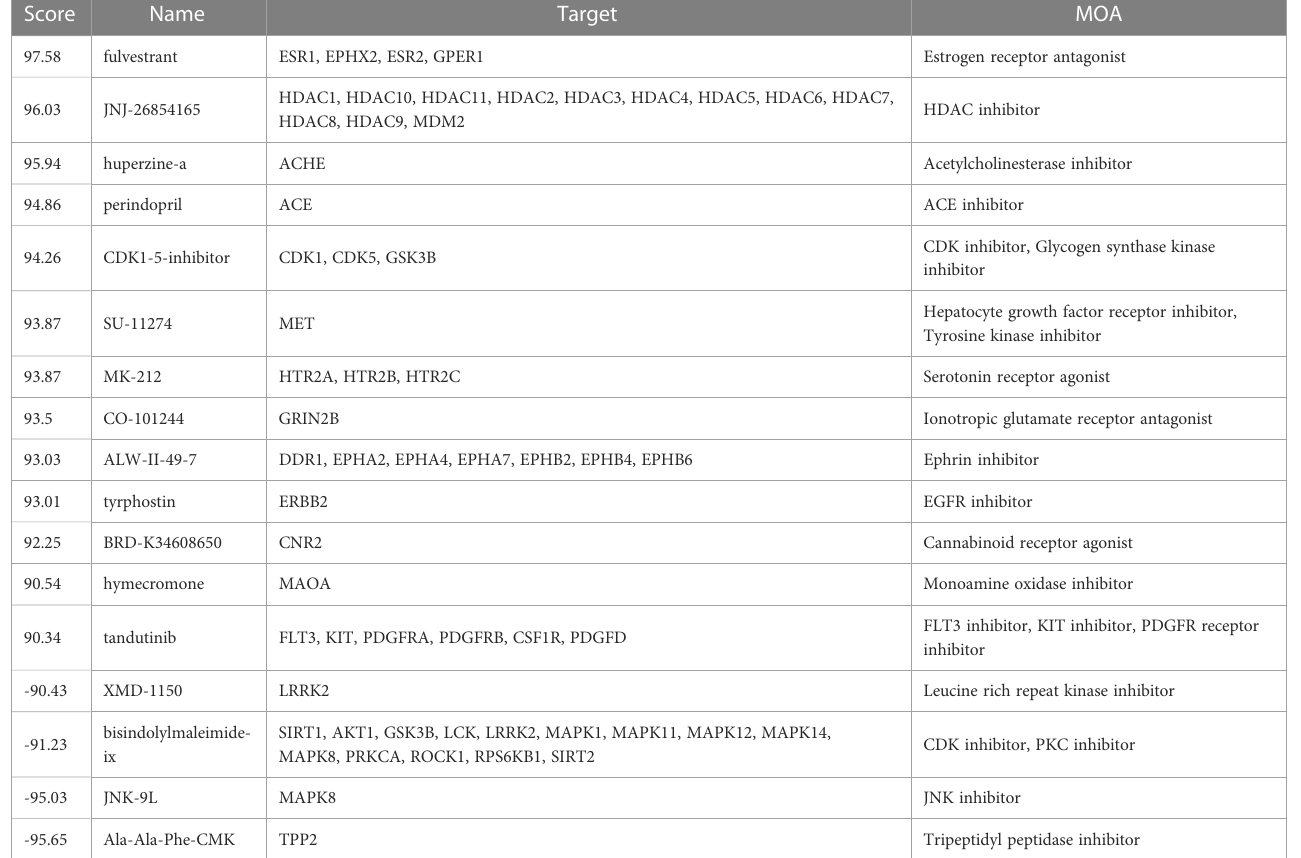
TABLE 3 Information of Top 8 prospective drugs with signi fi cant scores for the treatment.